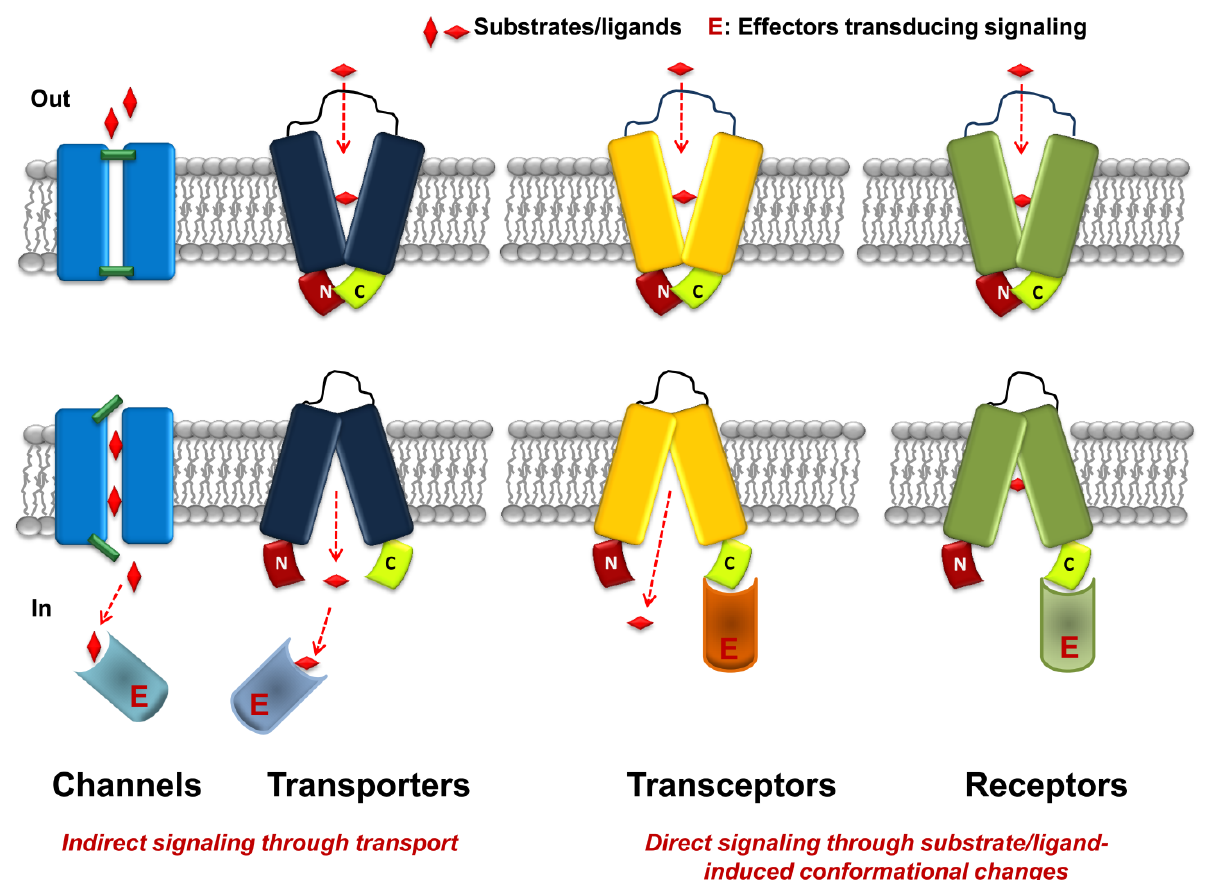
FIGURE 1: Highly speculative and simplified scheme comparing transporters, channels, transceptors and receptors. In channels ion transport (red vertical rhombs) is controlled by the simultaneous opening and closing of gates (green bars). Transporters, transceptors and receptors are shown to alternate from outward- to inward-facing conformations as a result of substrate or ligand (horizontal rhombs) bind- ing. In the scheme the C-terminal domain of receptors and transceptors is arbitrary considered to be the domain recognized, specifically in its inward topology, by the downstream effector protein (E), which transduces the relative